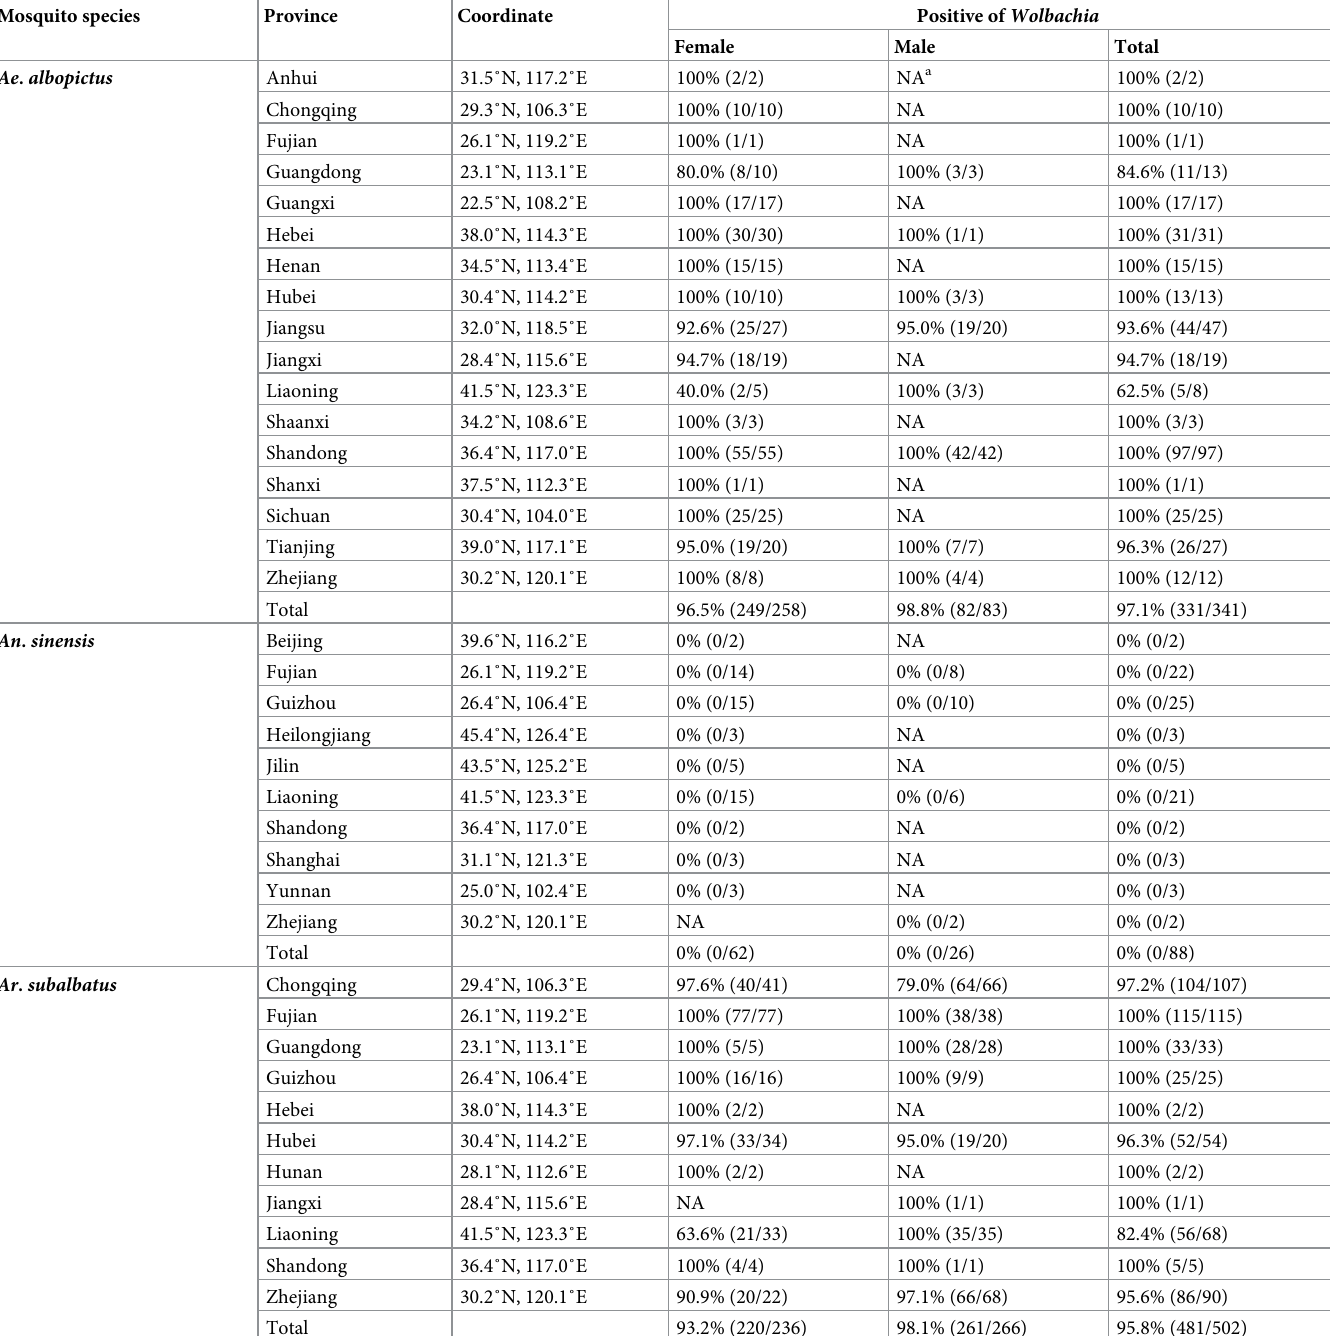
Table 2. The presence and positive rates of Wolbachia in mosquitoes collected from 24 provinces of China. Mosquito